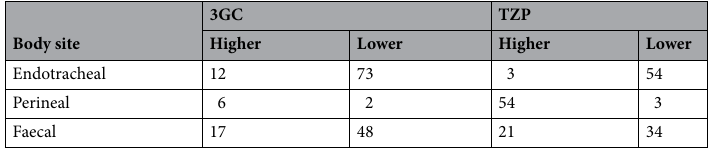
Table 1. The number of OTUs with significantly different abundances in each antibiotic treatment compared to the control group. Data obtained through LEfSe analyses between the relative abundance of bacterial OTUs in each antibiotic treatment (3GC-third-generation cephalosporins, TZP-piperacillin/tazobactam) and control group (no β-lactams) for each body